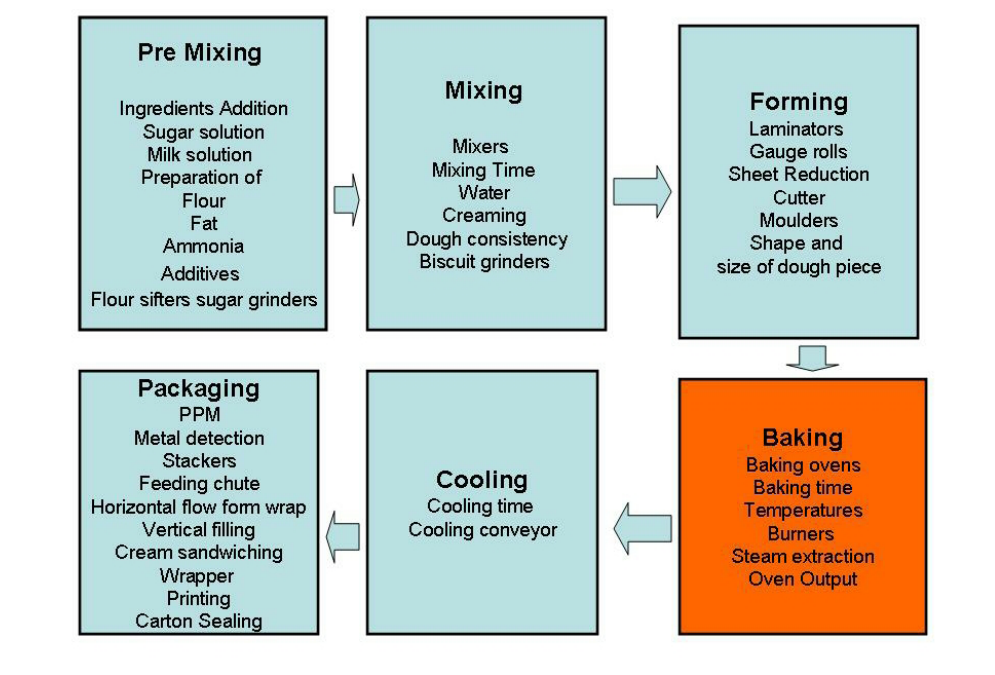
Fig 1. Flow chart for the production of